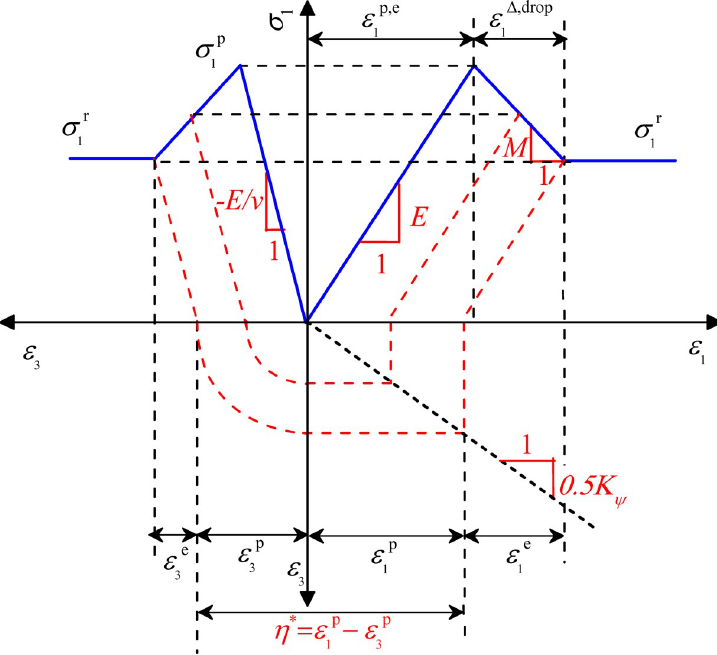
Fig 7. Simplified stress-strain curve of